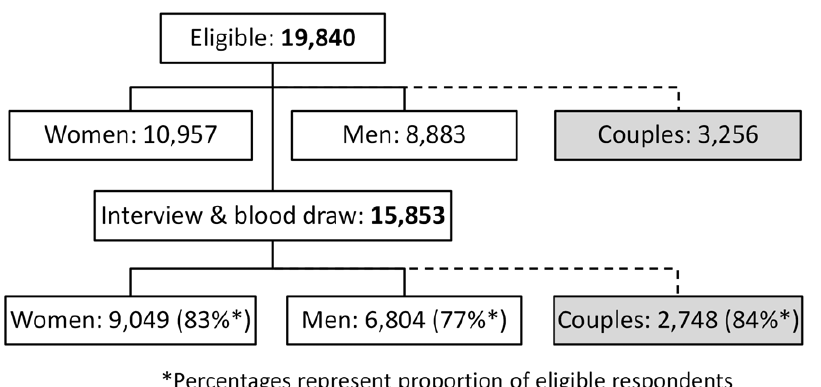
Figure 1. Eligibility, response rates and available married or cohabitating couple data, Kenya AIDS Indicator Survey 2007.